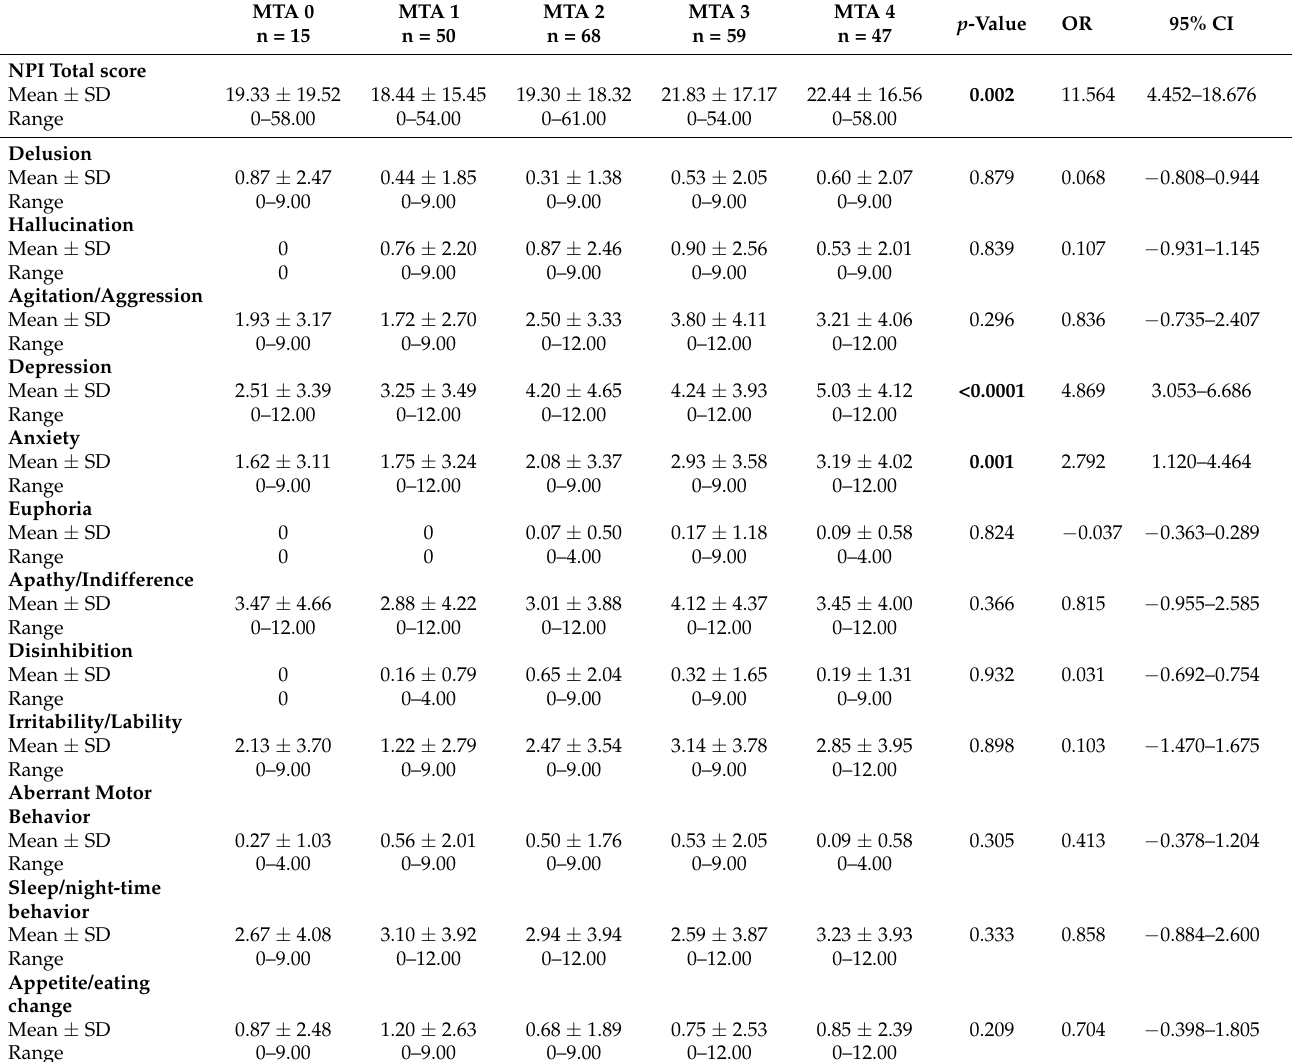
In Table 2, the association of the MTA score and NPI domains, adjusted by cognitive impairment presence/absence and severity, is shown. Depression and anxiety increased according to the MTA severity (NPI-Depression, OR = 4.869; 95% CI = 3.053-6.686; p < 0.0001 and NPI-Anxiety, OR = 2.792; 95% CI = 1.120–4.464; p = 0.001), while the other NPI domains did not show significant differences. Table 2. Association of MTA score and NPI domains, adjusted by cognitive impairment pres- ence/absence and